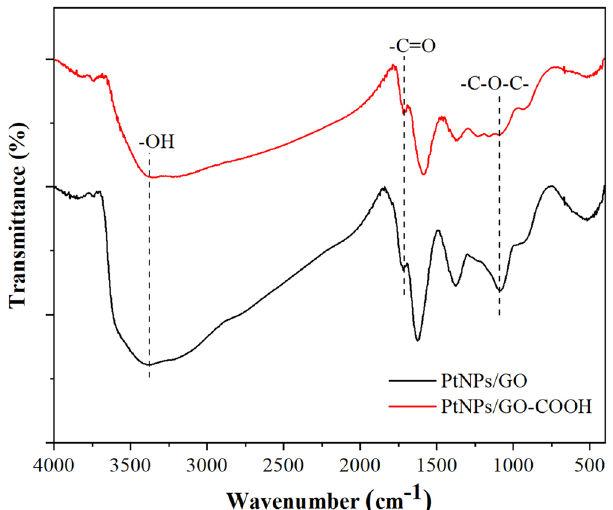
Figure 3. FTIR spectra of PtNPs/GO and PtNPs/GO-COOH.